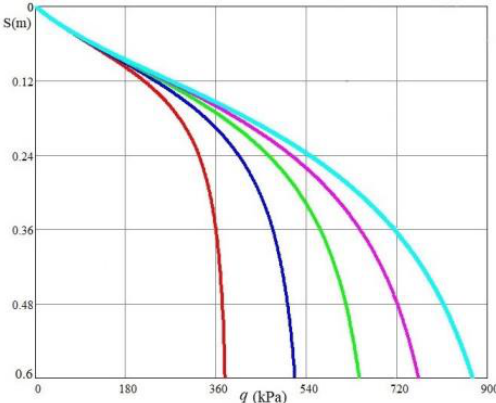
Figure 10. The dependency curve between total settlement S ( q ) , calculated by Equation (35), and load q with various values of pre-overburden pressure σ P and foundation depth z .